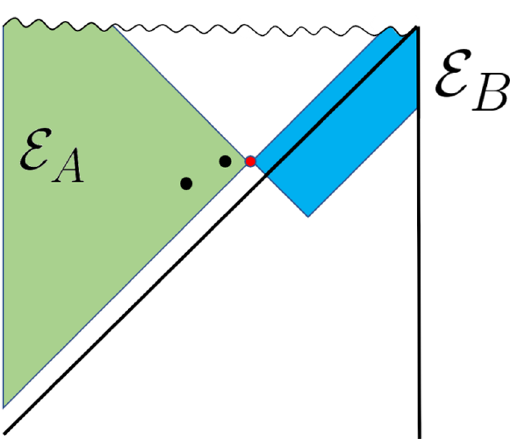
Figure 19 . The covariant bulge surface (black) at late times (i.e. for the ‘reverse’ sweep) consists of two spheres (or points in two dimensions). Both lie slightly inside the EW surface (red), which determines the Hawking radiation entanglement wedge of the system containing the black hole (blue).